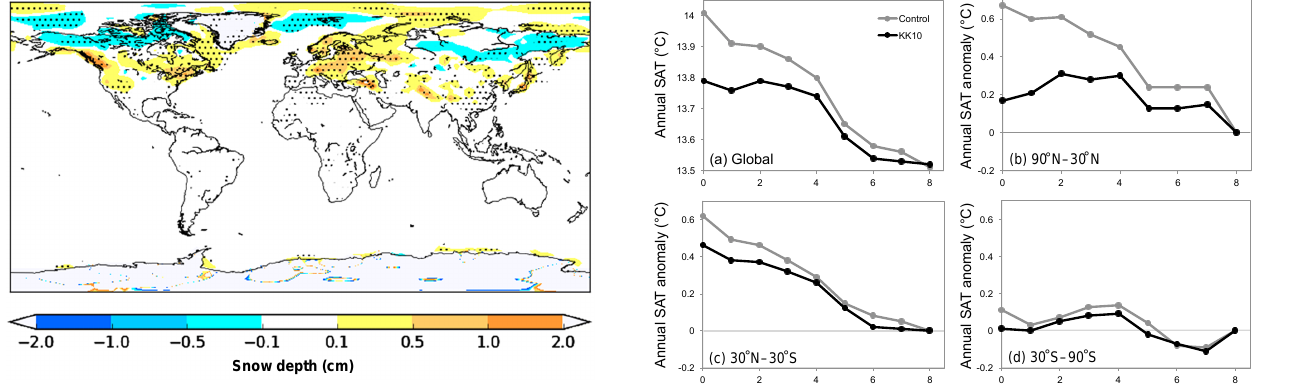
Figure 13. Time series plots for the Holocene simulations from HadCM3. Panel (a) : annual mean global surface air temperature (SAT) for the control simulation in grey, and KK10 simulation in black; panel (b) : anomaly in northern extratropical (30–90 ◦ N) an- nual mean temperature from the equivalent simulation at 8kaBP; panel (c) : same as (b) but for the tropics (30 ◦ N–30 ◦ S); panel (d) : same as (b) but for the southern extratropics (30–90 ◦